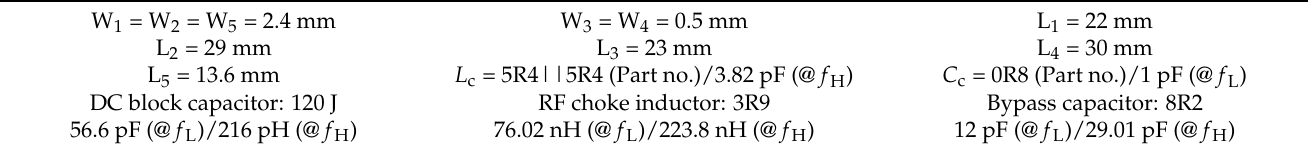
Table 3. Physical dimensions and component value of fabricated PCB.